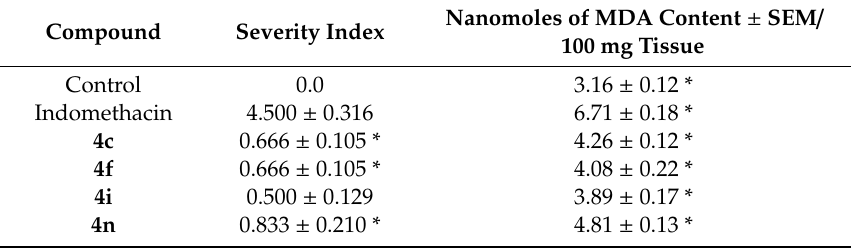
Table 3. Ulcerogenic activity and lipid peroxidation of 1-(substituted phenyl amino methyl)-3-(2-(4-(2-